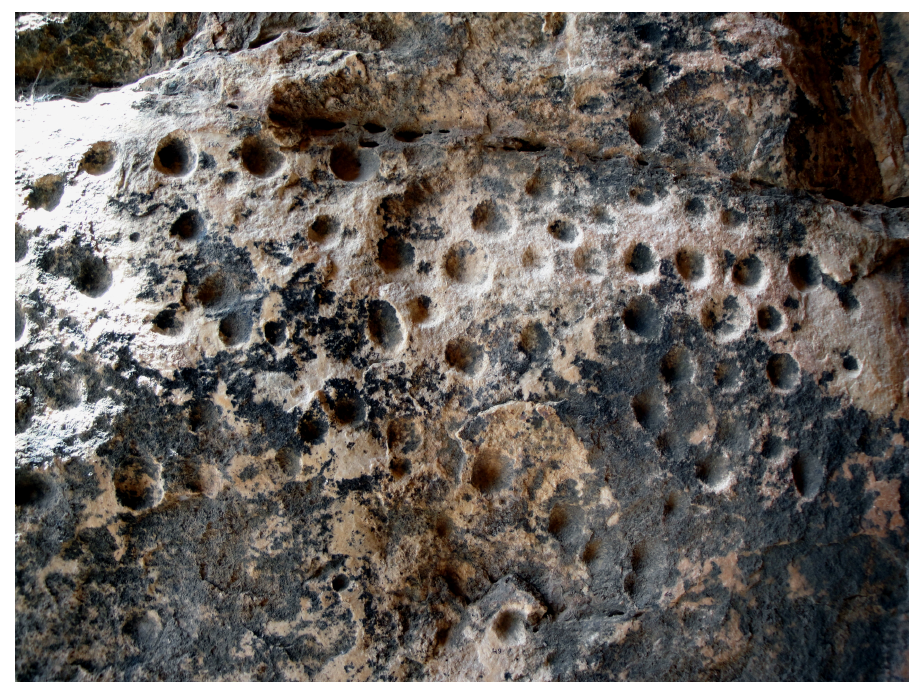
Figure 5. Big saucer shaped cupules in DC.